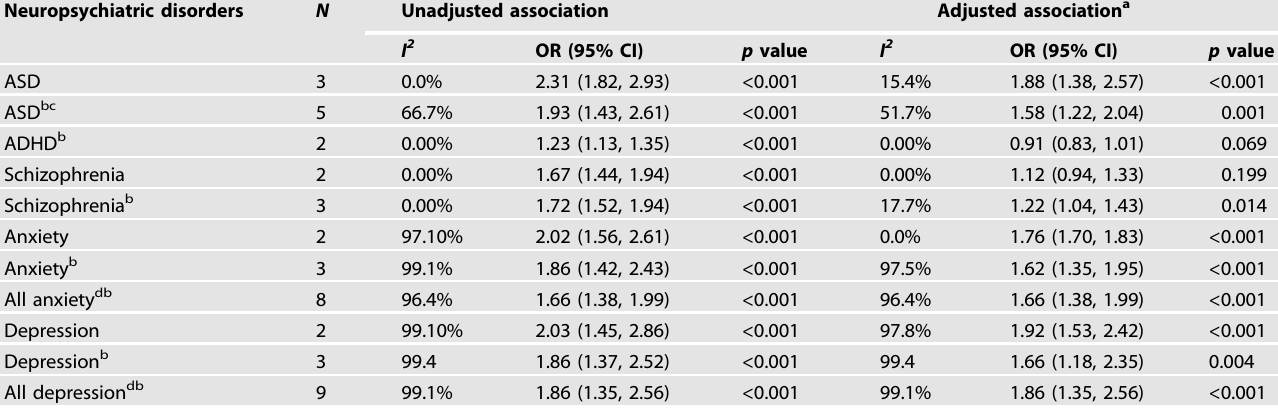
Table 4. Association between PCOS and neuropsychiatric disorders in women of reproductive age. Neuropsychiatric